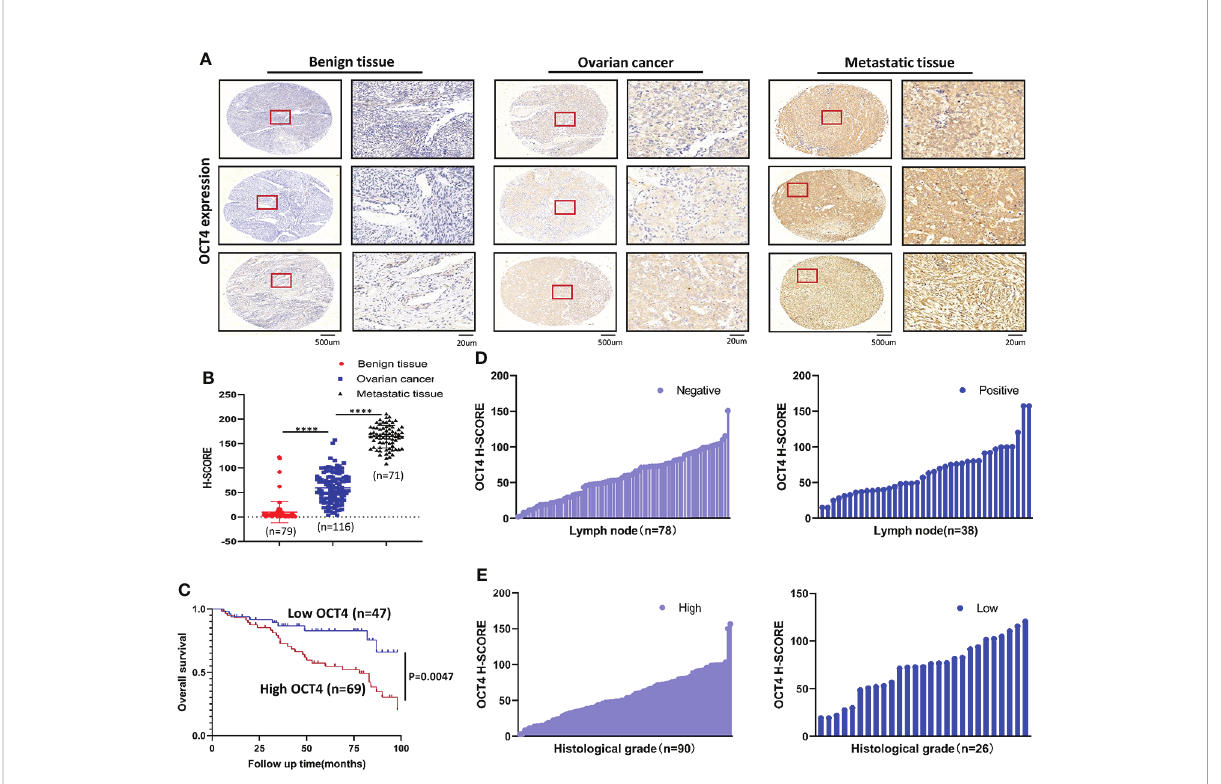
FIGURE 1 OCT4 IHC staining and survival analysis (A) Representative IHC staining of OCT4 in benign ovarian cyst tissues, OC tissues, and matched omental metastatic tissues. (B) Quanti fi cation of OCT4 H-score in different tissues. (C) OS of OC patients with low/high OCT4 H-score. (D) Expression rate of OCT4 in OC with or without lymph node metastasis. (E) Expression rate of OCT4 in high/low histological grade OC. (Data were expressed as the mean ± SD. Signi fi cance was calculated using Student ’ s t-test. ****,